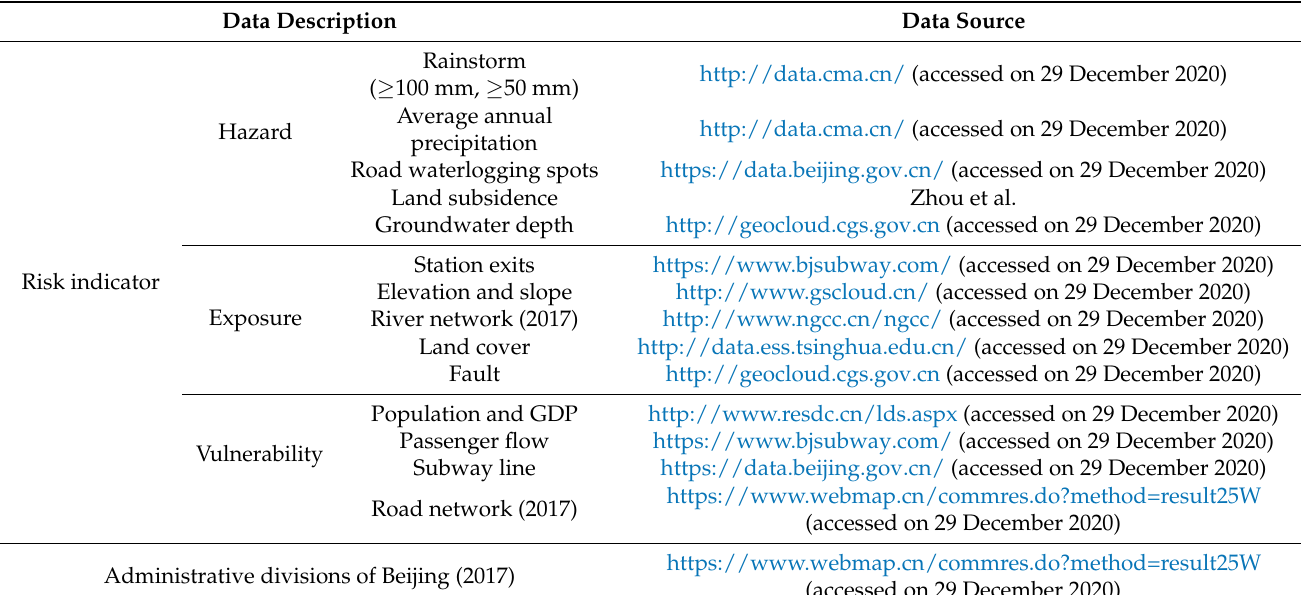
Table 2. Data sources of flood risk assessment